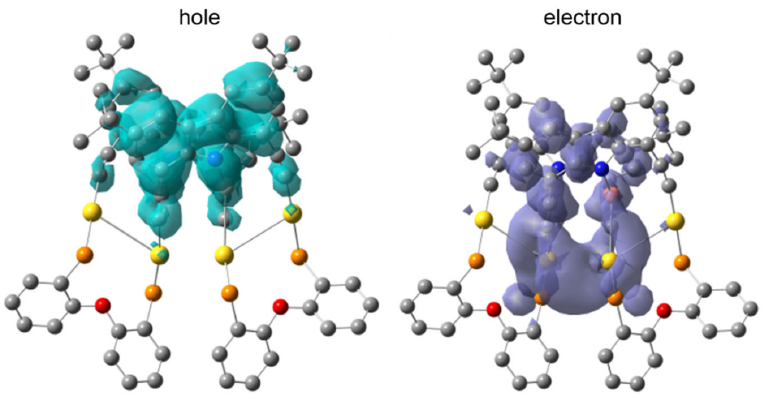
Figure 3. Plots of the hole and electron involved in the lowest-energy emission transition of Au 4 Cu 2 cluster by TD-DFT method at the PBE1PBE